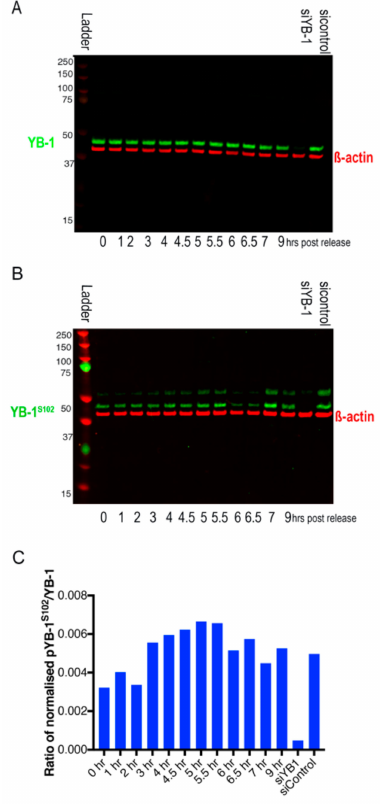
Figure 6. Western Blots from A549 cells following release from double thymidine block. Timepoints at which cells were harvested are shown below each of the blots. ( A ) YB-1, as detected by rabbit anti-YB-1 polyclonal antibody is shown in green. β -actin, as detected with a mouse anti- β -actin antibody is shown in red. ( B ) YB-1 S102 , as detected by rabbit anti-phospho-YB1 ser102 (Cell Signaling Technology, Danvers, MA, USA) is shown in green. β -actin, as detected with a mouse anti- β -actin antibody is shown in red. The last two lanes show treatment with si-YB-1 5 (cid:48) -GGUCCUCCACGCAAUUACCAGCAAA-3 (cid:48) ) or a scrambled si-Control 5’-CCACACGAGUCUUACCAAGUUGCUU-3 from Invitrogen. ( C ) Ratio of pYB-1 S102 / YB-1 in A549 cells post 2T block. Densitometries for these westerns is shown in Table S4 (Supplementary